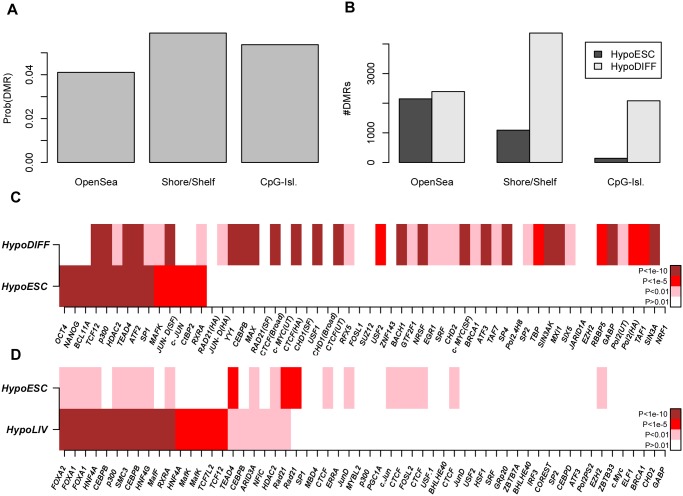
Identification of pluripotent and lineage-specific TFs by integration of Illumina 450k DNAm with ENCODE data.
A) Probabilities that a randomly picked open-sea, shore/shelf and CpG-island region is a DMR between pluripotent and differentiated cells (defined as the top 5% of DMRs). B) Relative numbers of DMRs hypomethylated within hESCs and differentiated cell types and within each regional class. C) Enrichment heatmap of transcription factor binding sites (as assessed in H1-hESC) for 58 TFs, among the DMRs hypomethylated in hESCs (HypoESC) and DMRs hypomethylated in differentiated cells (HypoDIFF). D) Enrichment heatmap of transcription factor binding sites (HepG2 line) for the top ranked 58 TFs, among DMRs hypomethylated in hESCs (HypoESC) and DMRs hypomethylated in liver cells (HypoLIV). In C-D), TFs have been ranked according to the significance of enrichment among HypoESC DMRs. Color codes: white (P > 0.01), pink (P < 0.01), red (P < 1e − 5), brown (P < 1e − 10). ChIP-Seq binding profiles of the same TF but generated by different labs are distinguished by an abbreviation of the corresponding lab: SF (Stanford), HA (Hudson-Alpha).